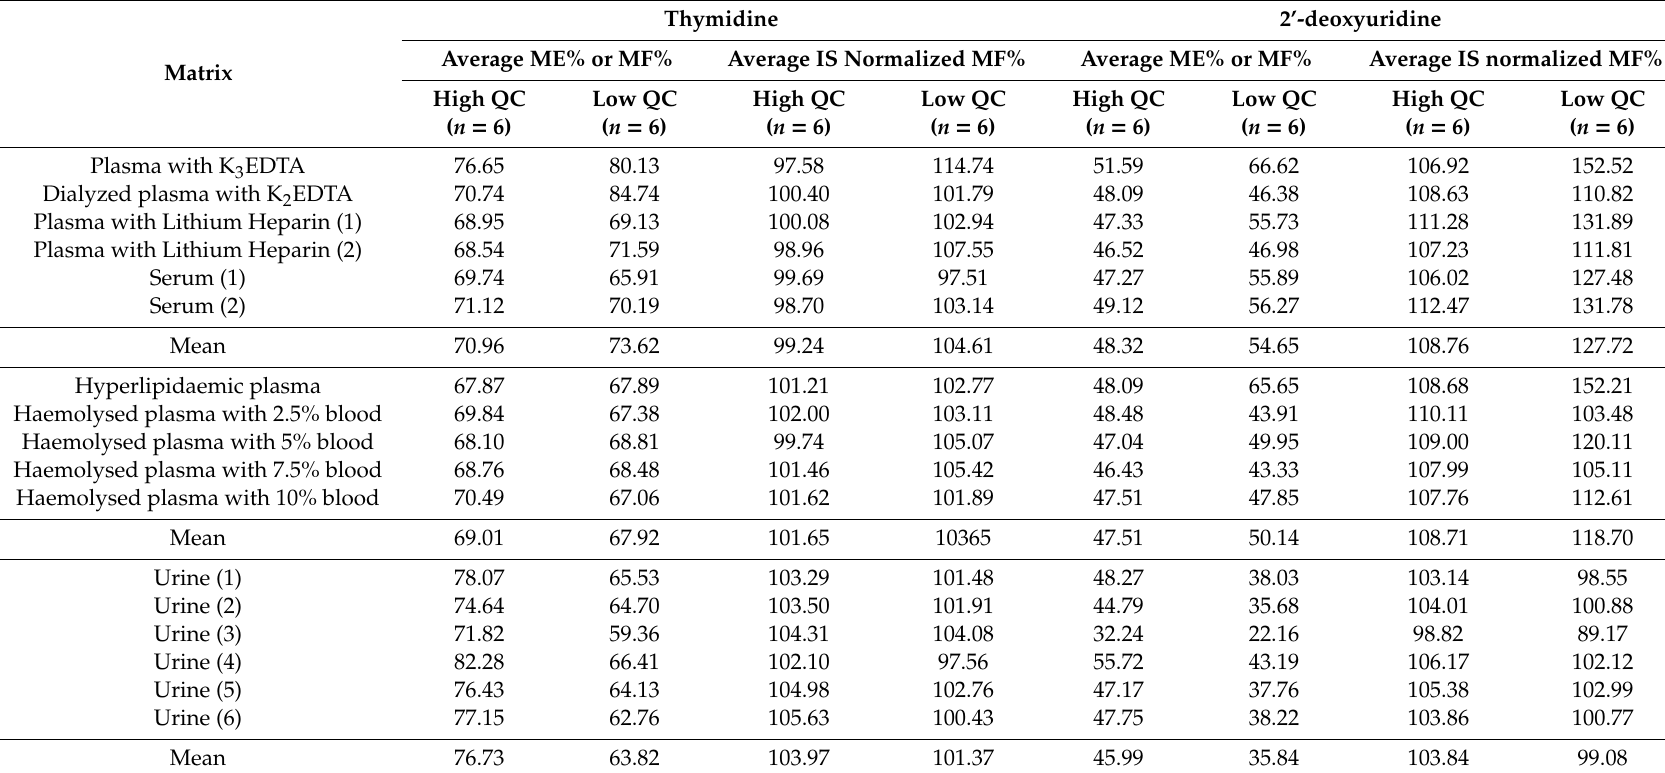
Table 2. Matrix e ff ects (ME%) or matrix factor (MF%) and IS normalized matrix factors for thymidine and 2’-deoxyuridine in plasma, serum and urine tested at two QC